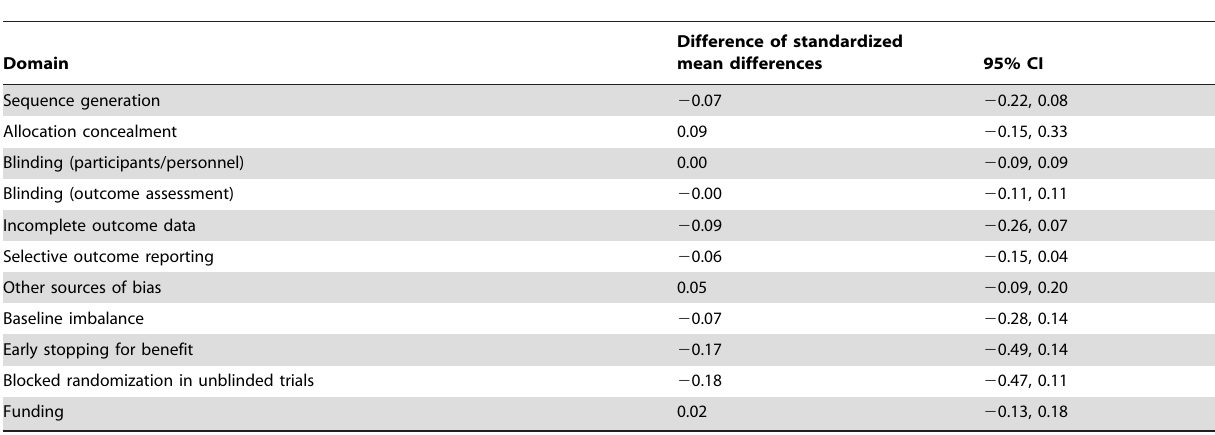
Table 3. Results of meta-epidemiological analysis of bias items and treatment effect